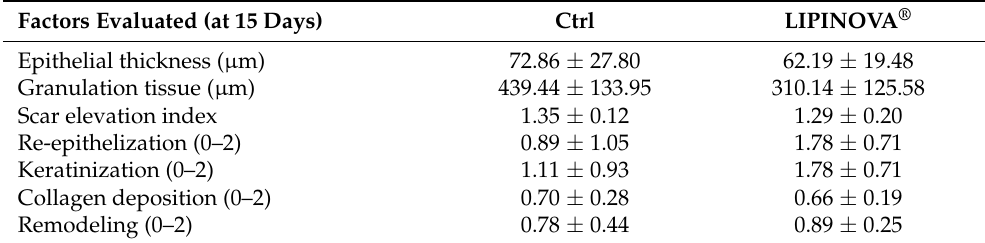
Table 2. Histological parameters analyzed in mice treated with saline or with 50 ng LIPINOVA ® . The study was performed at 15 days